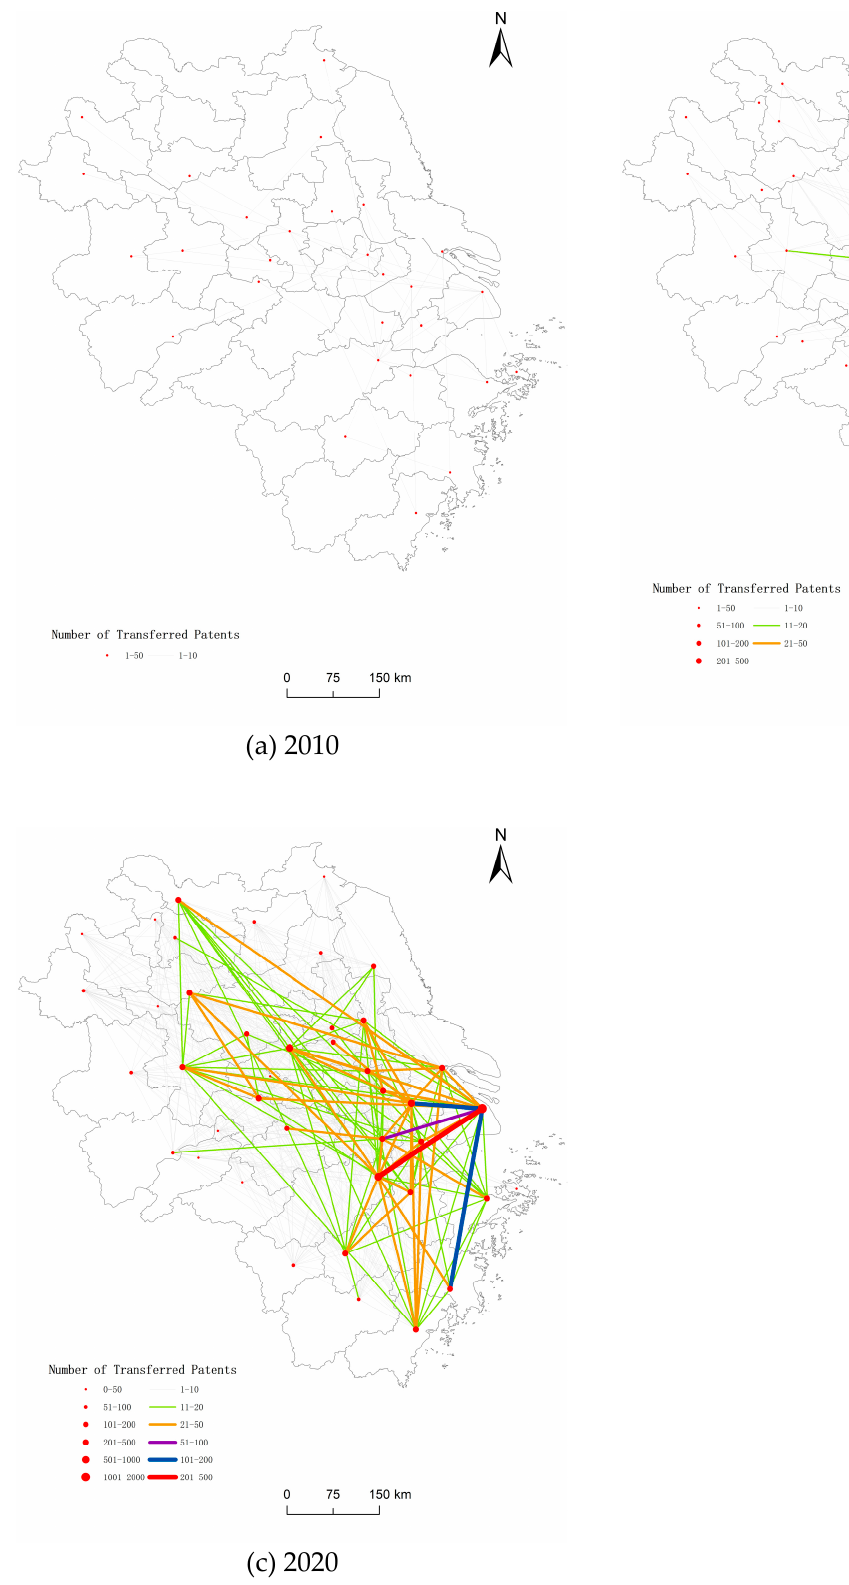
Figure 1. Green technology diffusion in YRD from 2010 to 2020. Data source: Patent Information Service Platform of Intellectual Property Press. Available online: http://search.cnipr.com/pages! advSearch.action (accessed on 13 January